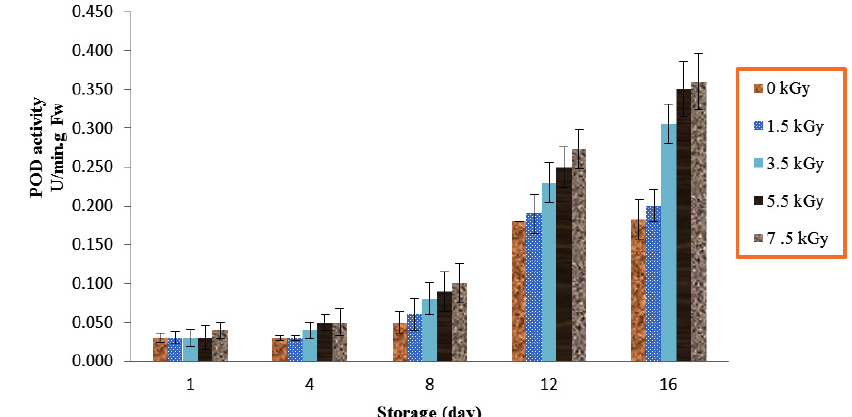
Fig. 1. Effect of Electron-Beam Irradiation on POD Activity in Agaricus Brunnescens fruit Bodies During Storage at 4 °C. Vertical Bars Represent the Standard Deviation about the Mean (r = 3)